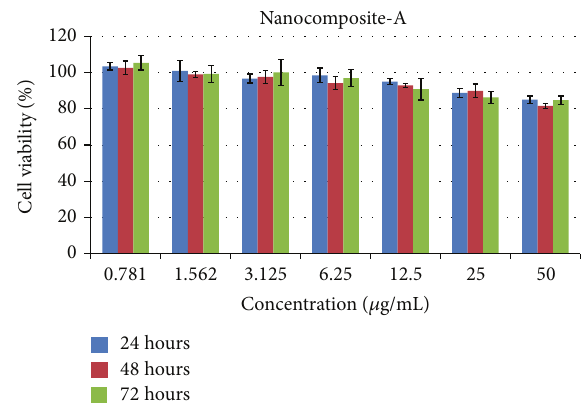
Figure 11: PAS-ZLH (nanocomposite-A) against mouse fibroblast cells